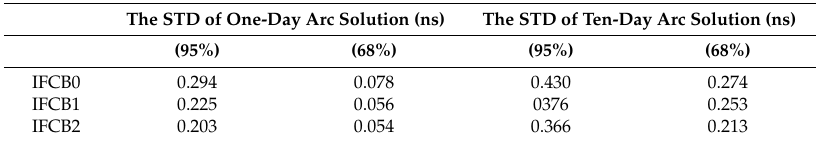
Table 9. The uncertainty (STD) of the GLONASS PPP solutions using German Research Center for Geosciences (GFZ) products with fixed coordinates (ns).